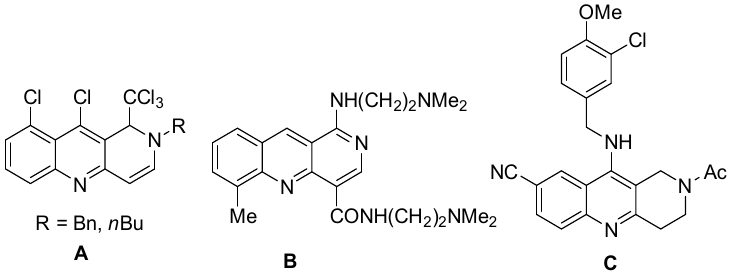
Figure 1. Biologically active derivatives of benzo[ b